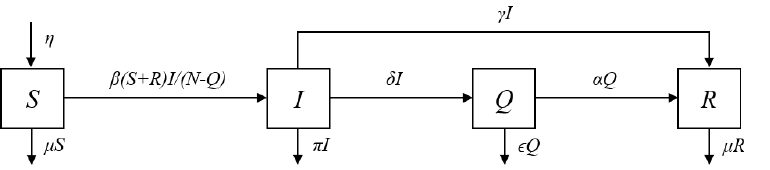
Figure 1. Transfer diagram for a SIQR model with quarantine-adjusted incidence. S is the class of susceptibles, I is the class of infectives, Q is the class of detected active cases, i.e., individuals tested positive and in isolation at a hospital or at home and R is the class of individuals who contracted the disease, were detected or not, and have recovered. The individuals in class R are considered permanently